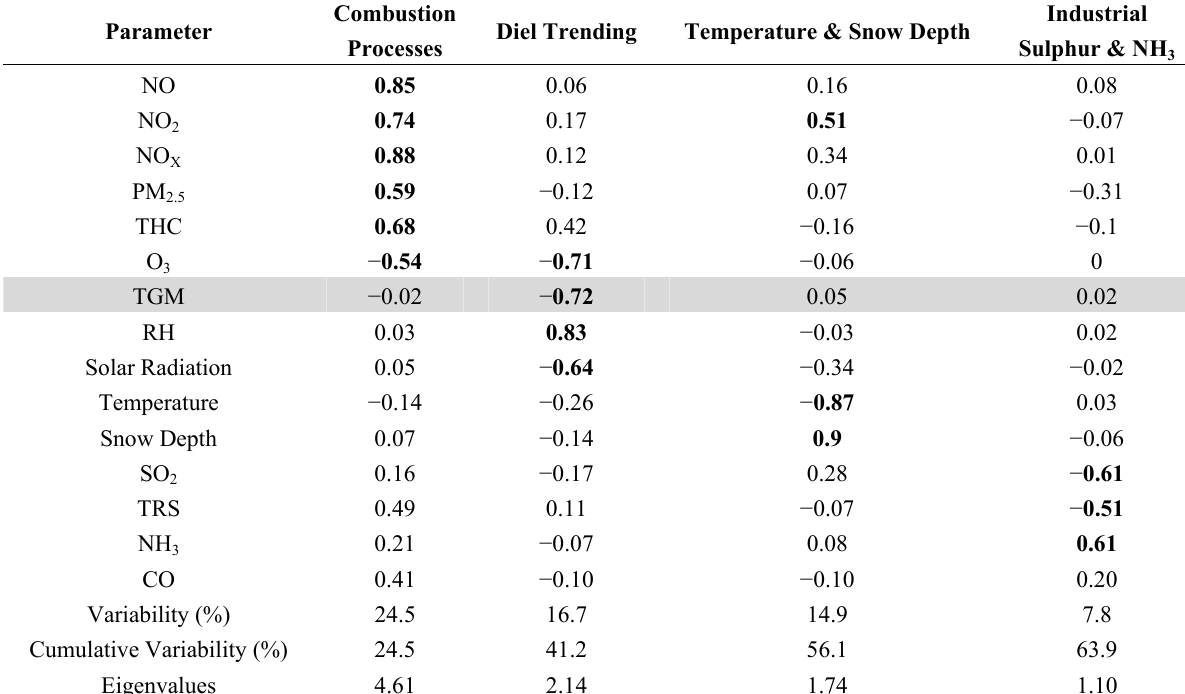
Table 4. PCA rotated factor loadings for lowest 1/3rd of de-trended/seasonally adjusted TGM concentrations ( i.e ., “low” TGM concentrations). Factor loadings with an absolute value greater than or equal to 0.5 are bolded. The shaded row highlights TGM loadings on each factor. Combustion Parameter Diel Trending Temperature & Snow Depth Processes